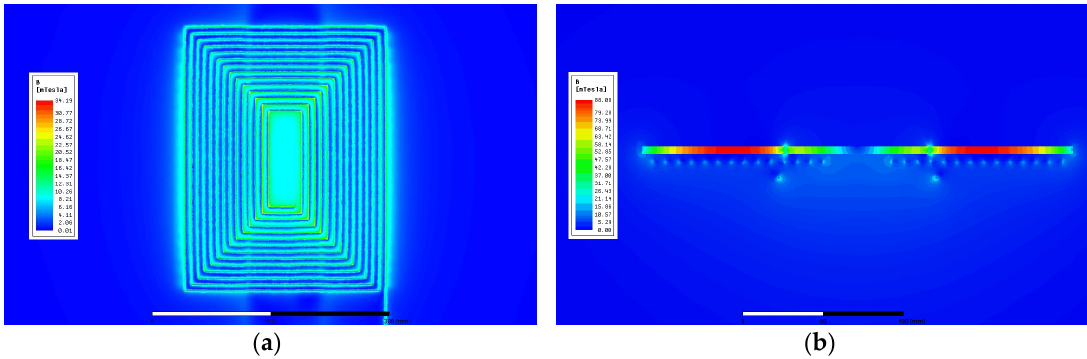
Figure 15. Finite Element Analysis (FEA) simulations with placement of the magnetic strip. ( a ) plan; ( b ) axial.